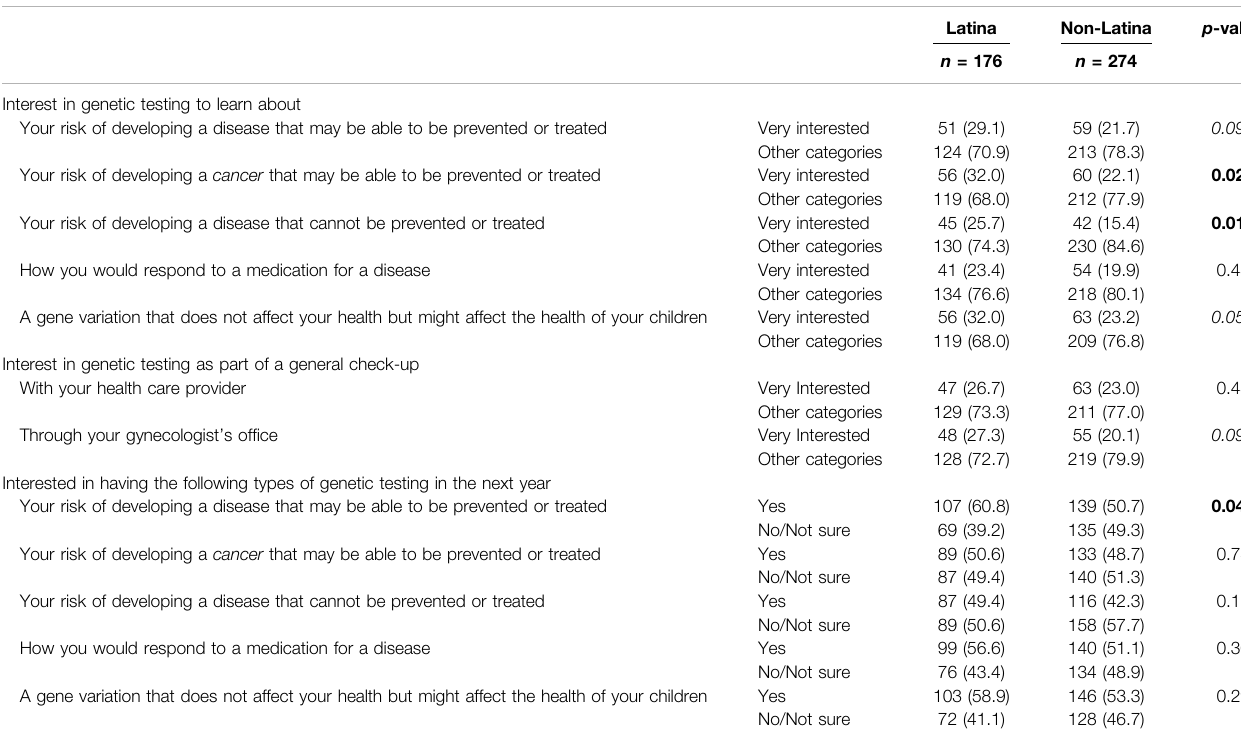
TABLE 4 | Bivariate associations between genetic testing interest and ethnicity ( n =